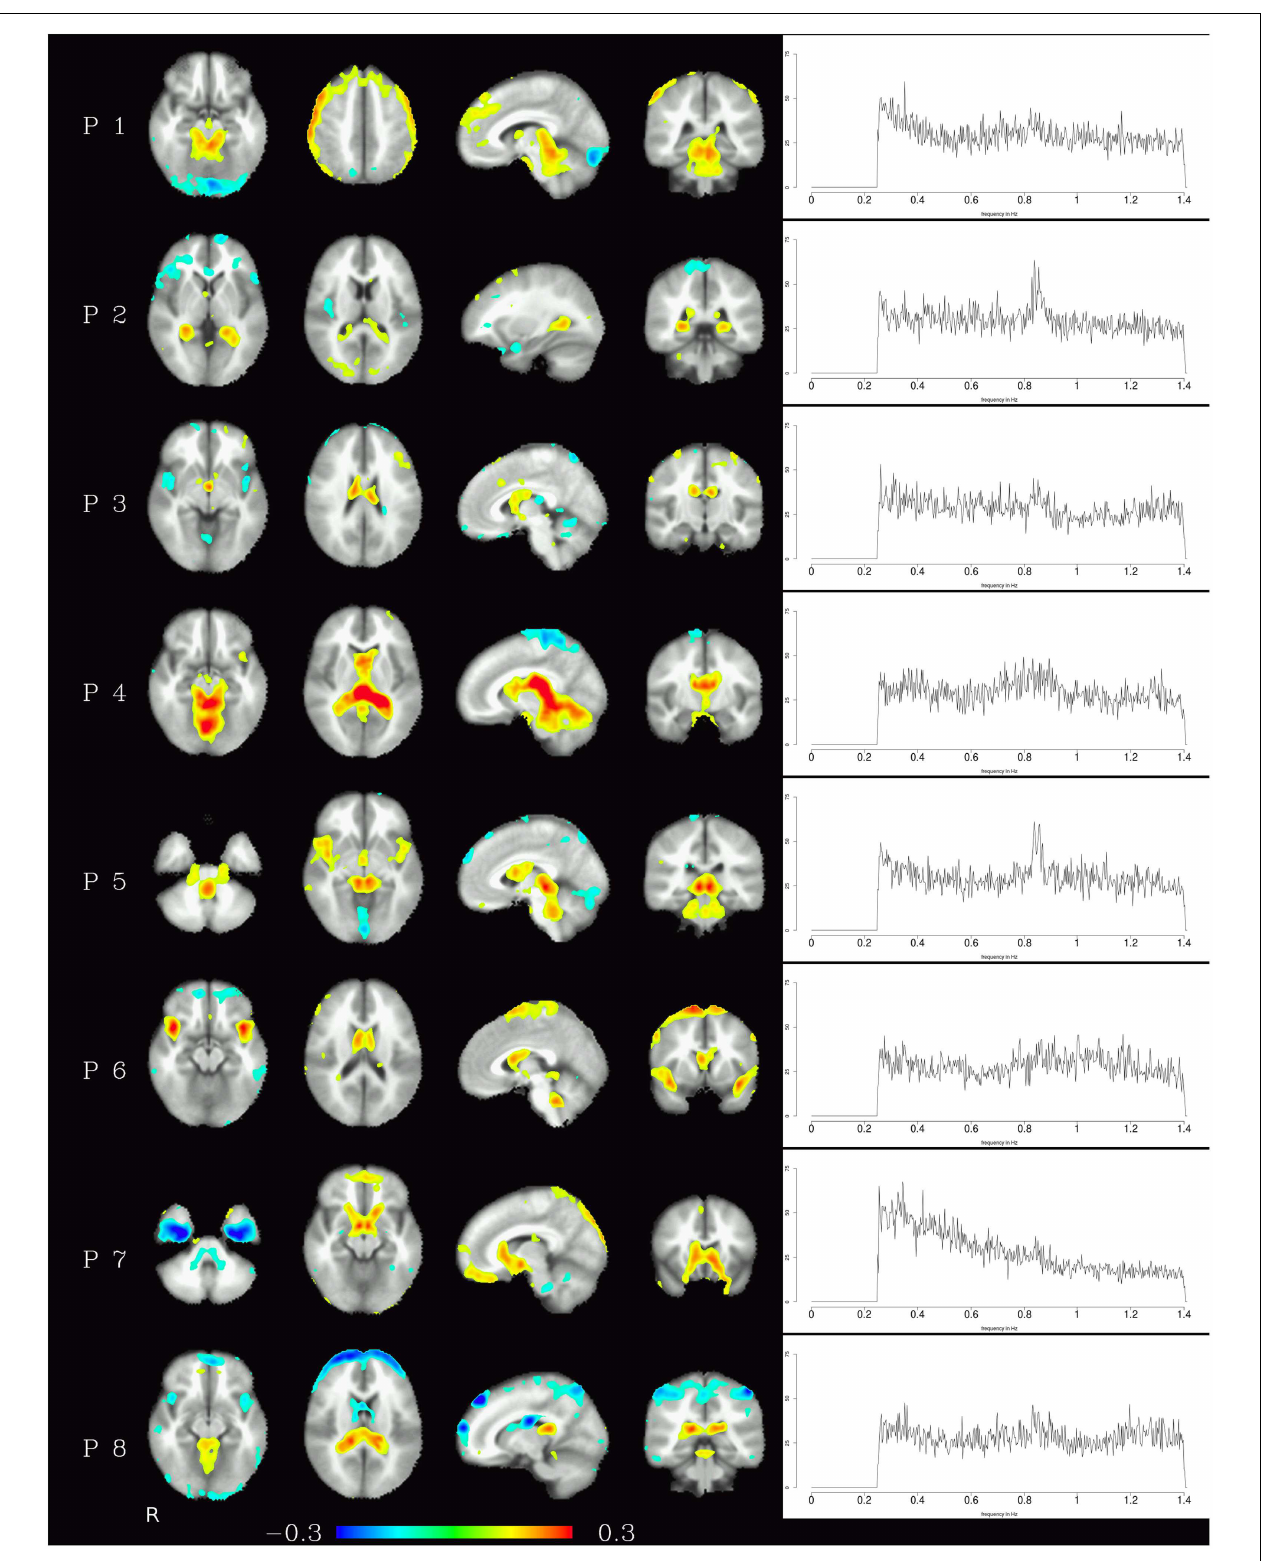
FIGURE 1 |Temporal ICA components attributed to pulsation in ventricles and large blood vessels . Left: maps thresholded at 0.1 (weights in the mixing matrix). Right: frequency spectra corresponding to the ICA components represented on the left.